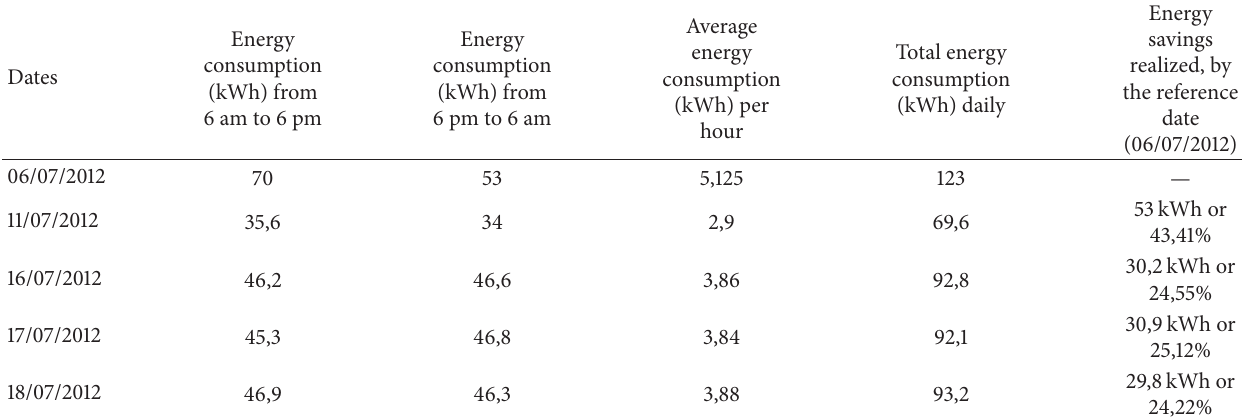
Table 9: Comparison between energy consumption of the site, case of a day not applying the proposals of energy savings (06/07/2012), case of a day for which the air conditioner was under failure, and case of days applying the proposals of energy savings (16, 17, and 18 July 2012): Missinguileo site.